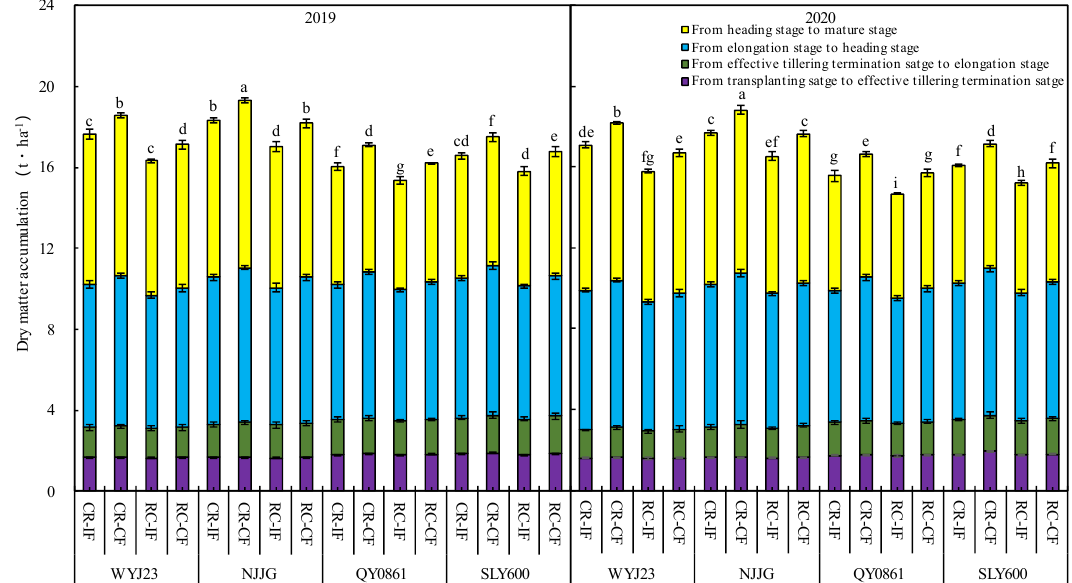
Figure 1. Dry matter accumulation of different rice varieties under two types of fertilizer treatments. The error bars were presented as the standard errors of the dry matter accumulation of transplanting stage to effective tillering termination stage, effective tillering termination stage to elongation stage, elongation stage to heading stage, heading stage to mature stage. Different lowercase letters indicate significant differences of dry matter accumulation at mature stage among all treatments of four va- rieties in the same year at the 5% level according to LSD tests (0.05).